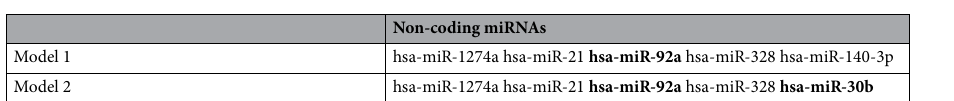
Table 1. Best out-of-sample SWAG models that achieve a perfect classification in terms of area under the curve (i.e. AUC = 1 ). The non-coding miRNAs are displayed in order of presence in the SWAG chain. The antagonistic miRNAs are presented in bold.